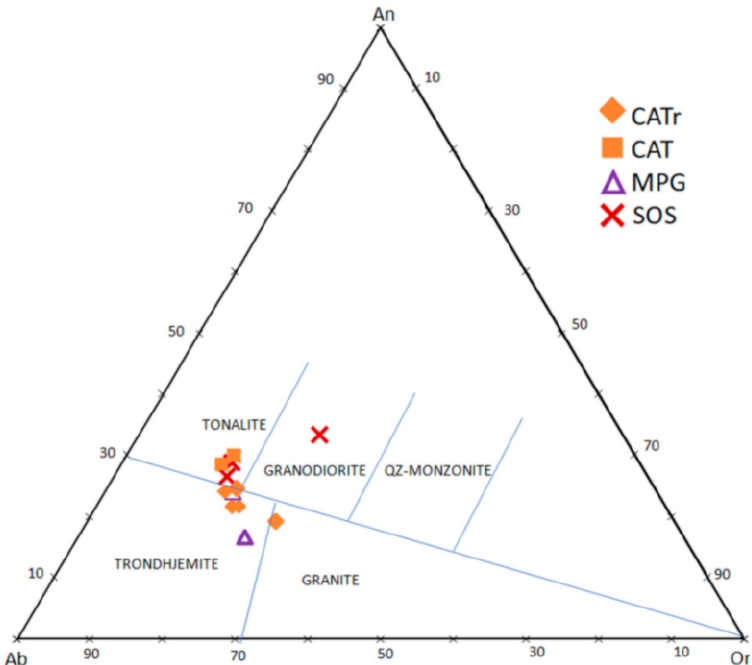
Figure 8. Ab–An–Or ternary diagrams for Corno Alto-M. Ospedale felsic samples. After Barker [77]. An efficient classification method for feldspathic igneous rocks is the MALI vs. SiO 2 diagram (Figure 9; Frost and Frost, 2008 [78]). All Corno Alto-M. Ospedale rocks plot in the lowest calcic field close to the calcic–calc-alkalic boundary (some samples fall onto